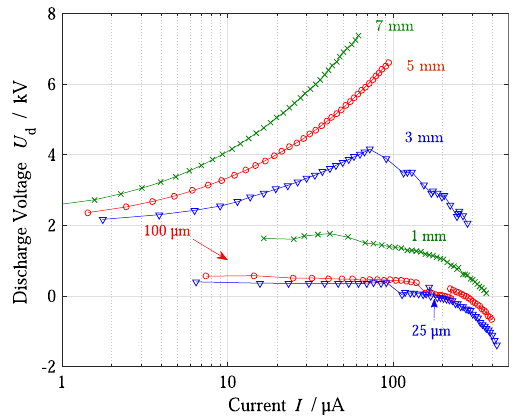
Figure 4. Variation of voltage U d with mean current I associ- ated with a microstructured electrode array: two electrodes with 170 points and a wire electrode (see Fig. 2). Comparison between experimental data ( (cid:4)(cid:4)(cid:4) ) and empirical model ( – ), Equation (2), with the adjusted parameters U s ’ 820 V and R d ’ (cid:2) 1.9 M X deduced from a least squares method.